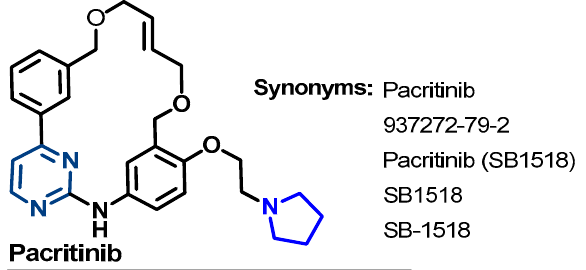
Figure 39. Chemical structure, name, and synonyms of pacritinib.